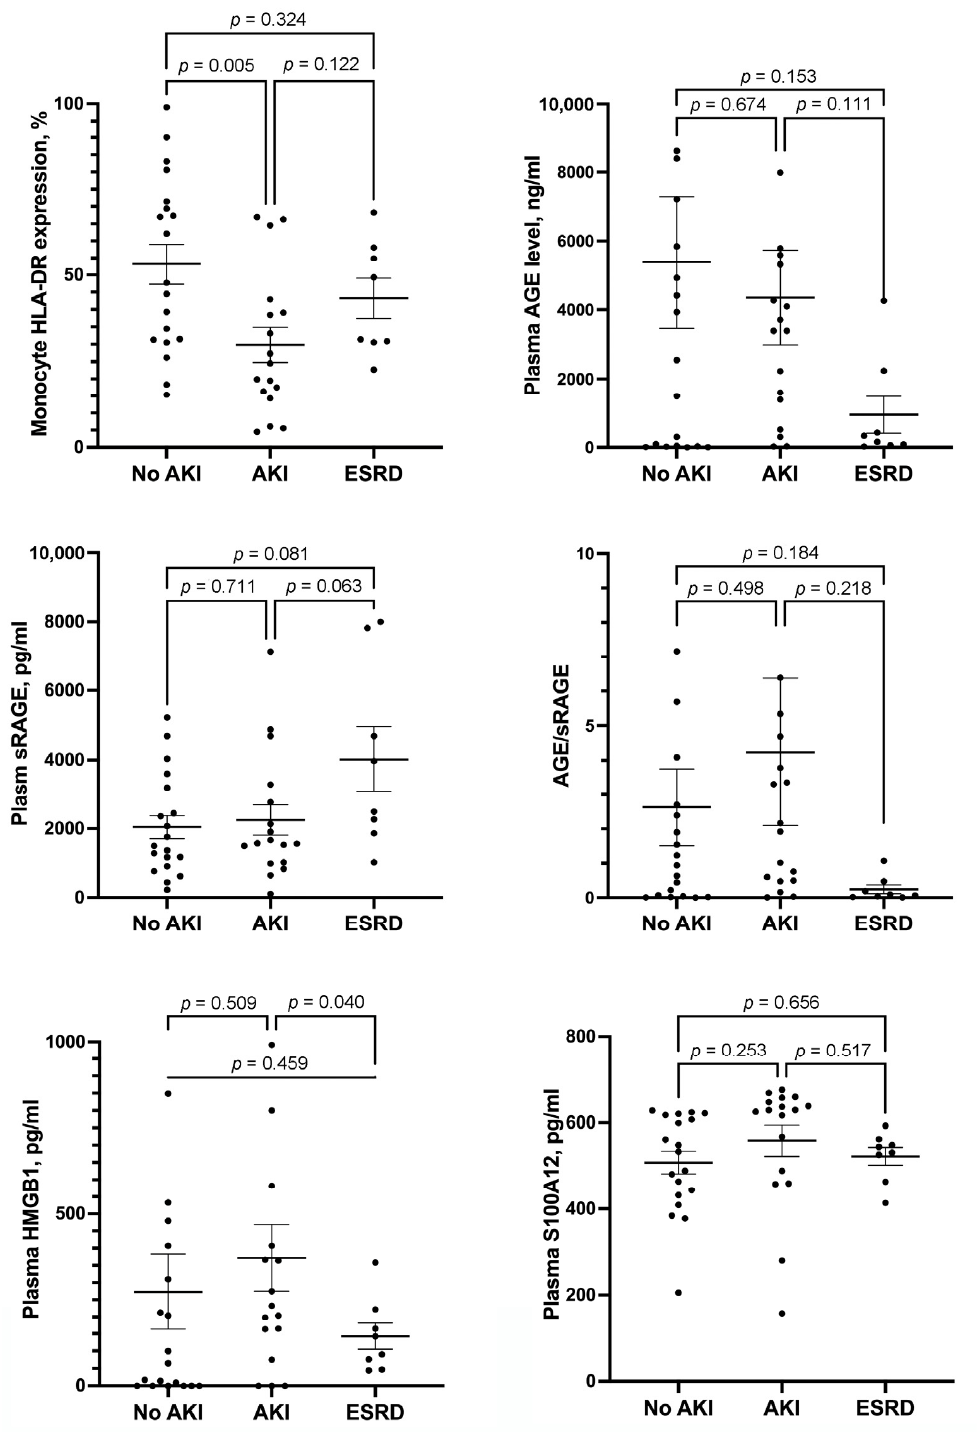
Figure 2. Scatterplots showing the levels of monocyte HLA-DR expression, plasma AGE, plasma sRAGE, AGE/sRAGE ratio, plasma HMGB1, and plasma S100A12 among septic patients with and without AKI and those with ESRD. Error bar represents mean and standard error mean. HLA = human leukocyte antigen; AGE = advanced glycation end products; sRAGE = soluble receptor for AGE; HMGB1 = high-mobility group box 1; AKI = acute kidney injury; ESRD = end stage renal dis- ease.